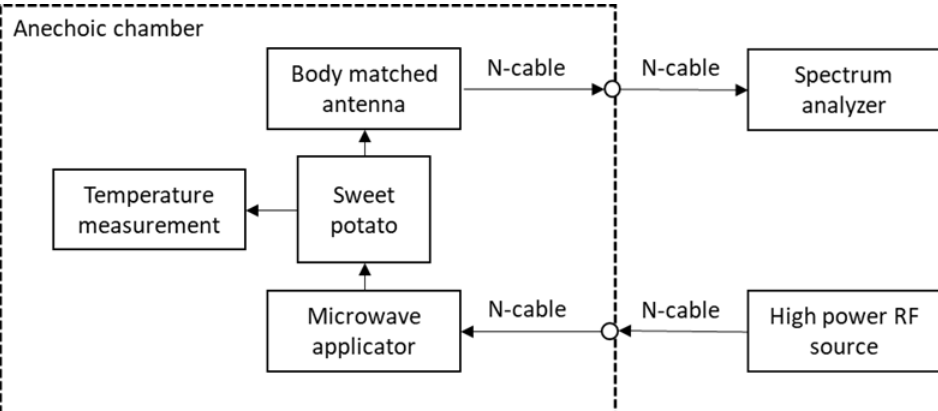
Figure 1. MWA experiment